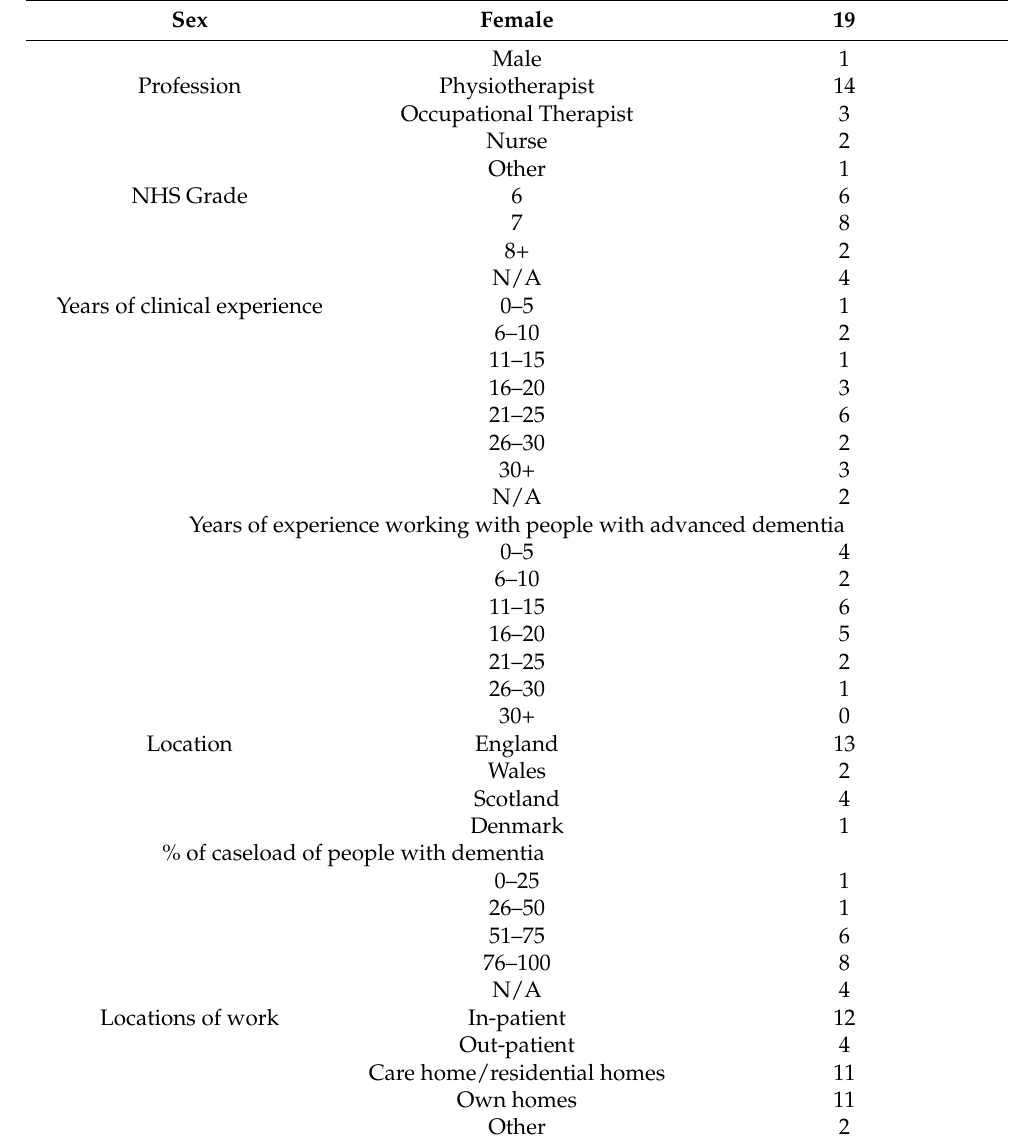
Table 1. Characteristics of participants ( n =